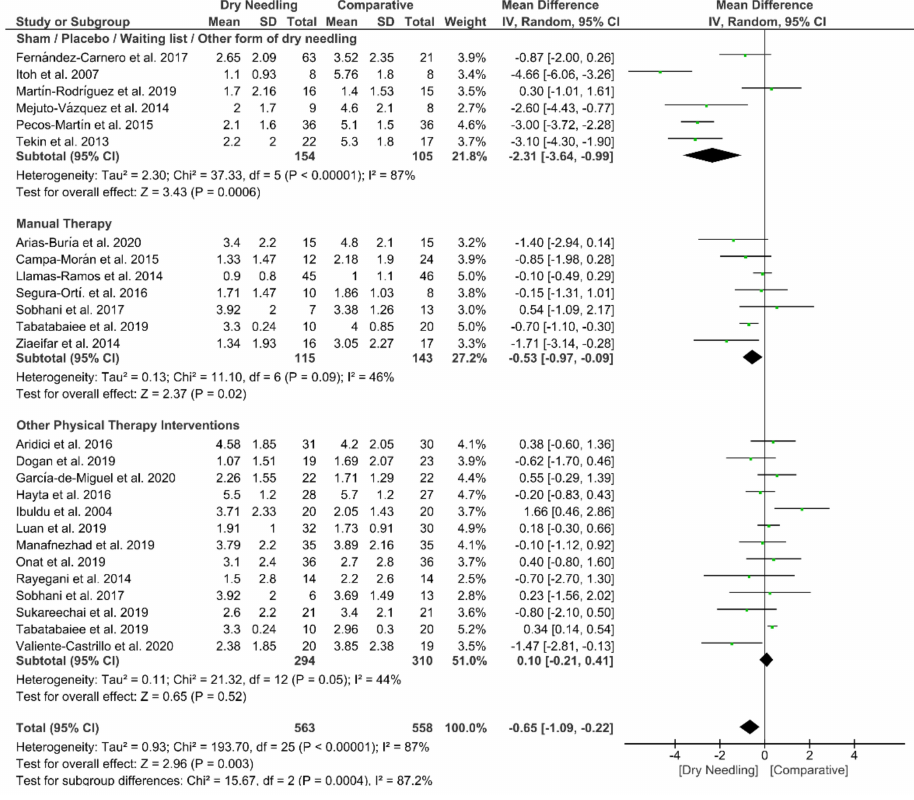
Figure 4. Mean di ff erences (MD) comparing the short-term e ff ects of dry needling alone against sham / placebo / waiting list / other forms of dry needling or manual therapy or other physical therapy. SD: standard deviation; CI: confidence